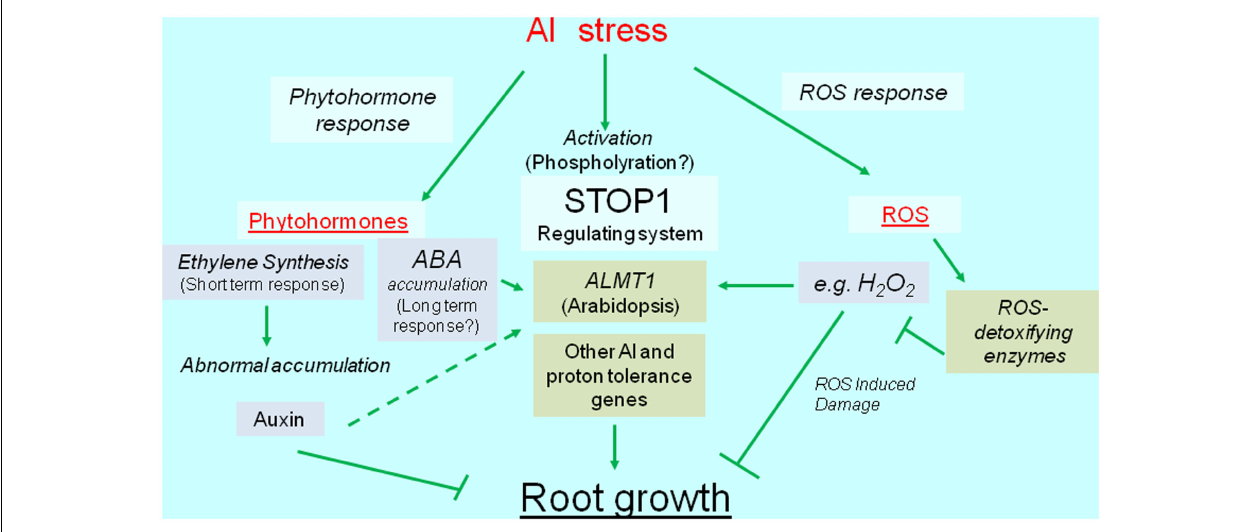
FIGURE 1 | Diagrammatic representation of transcriptional regulation of Al tolerance genes. Al stress activates transcription of Al tolerance genes (green box), which are regulated the transcription via phytohormone, SENSITIVE TO PROTON RHIZOTOXICITY1 (STOP1), and reactive oxygen species (ROS) mediated pathways. The major Al tolerance gene, such as ALUMINUM ACTIVATED MALATE TRANSPORTER1 ( ALMT1 ) -type malate transporter, is regulated the transcription by STOP1-like protein, but it’s likely activated by phytohormone(s) and ROS. ROS induces various genes including ROS detoxifying